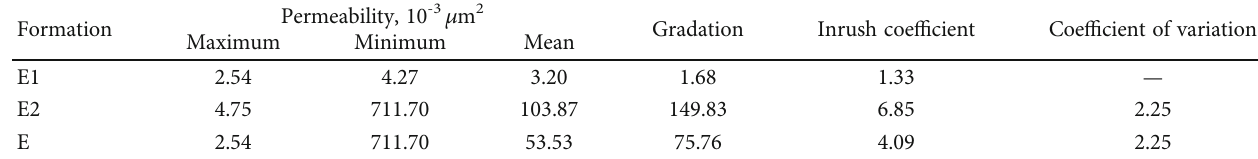
Table 9: Statistical table of heterogeneity parameters in the reservoir of Yingmai 7